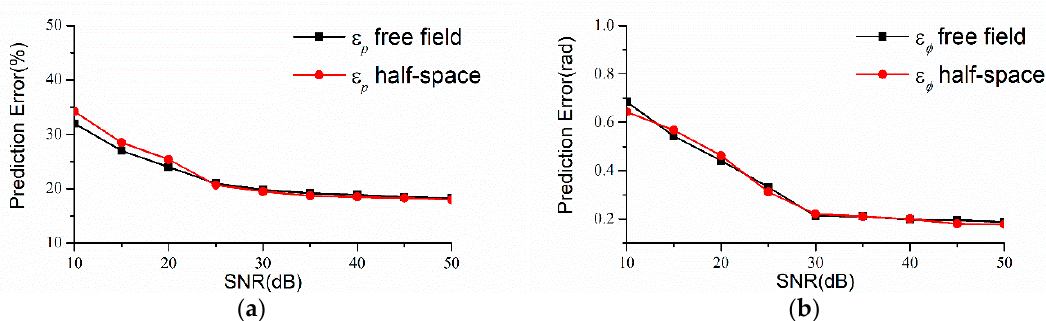
Figure 18. Prediction errors with the variation of the signal–noise ratio (SNR) ( f 0 = 300 Hz, h U = 0.2 m, 90 measurement points optimized with EFI). ( a ) ε p and ( b ) ε Φ .